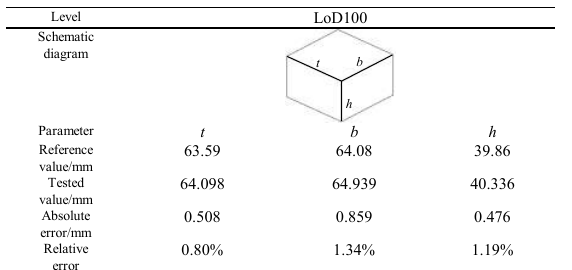
Table 5. Extraction results and accuracy of LoD100 of Ludou.